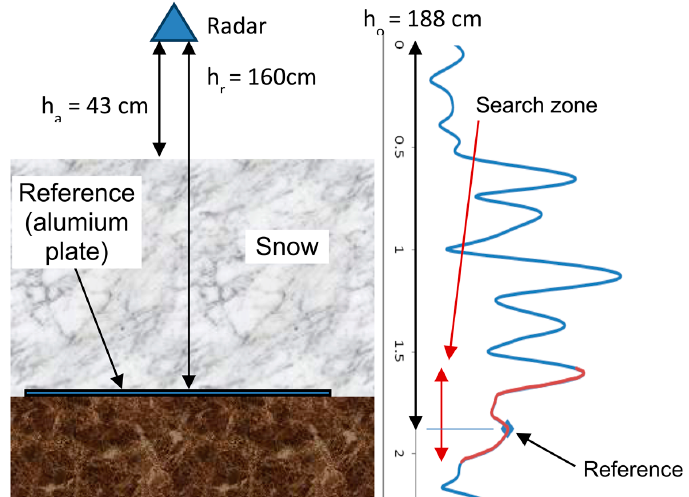
Figure 1. Schematic illustration of the radar retrieval. On the left, the radar is at a height h air above the snow, that is at a height ( h r ) above the ground, given a measured snow depth of h s = 117 cm. On the right, the measured radar signal expressed in “radar distance” is shown, with a series of peaks linked to different layers within the snowpack. The measured total radar distance is 188 cm between the radar and the last peak (i.e., the bottom). Knowing h s , one can retrieve the mean snow refractive index or permittivity(Equation (11)).